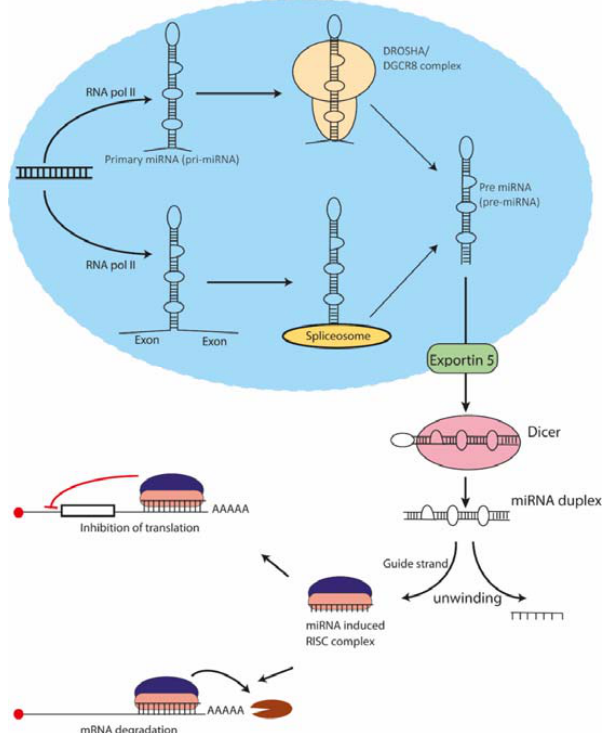
Figure 2. Biogenesis and mechanism of action of miRNAs. miRNAs are produced by two major pathways: canonical and non-canonical pathways. In the former, transcription by RNA pol II